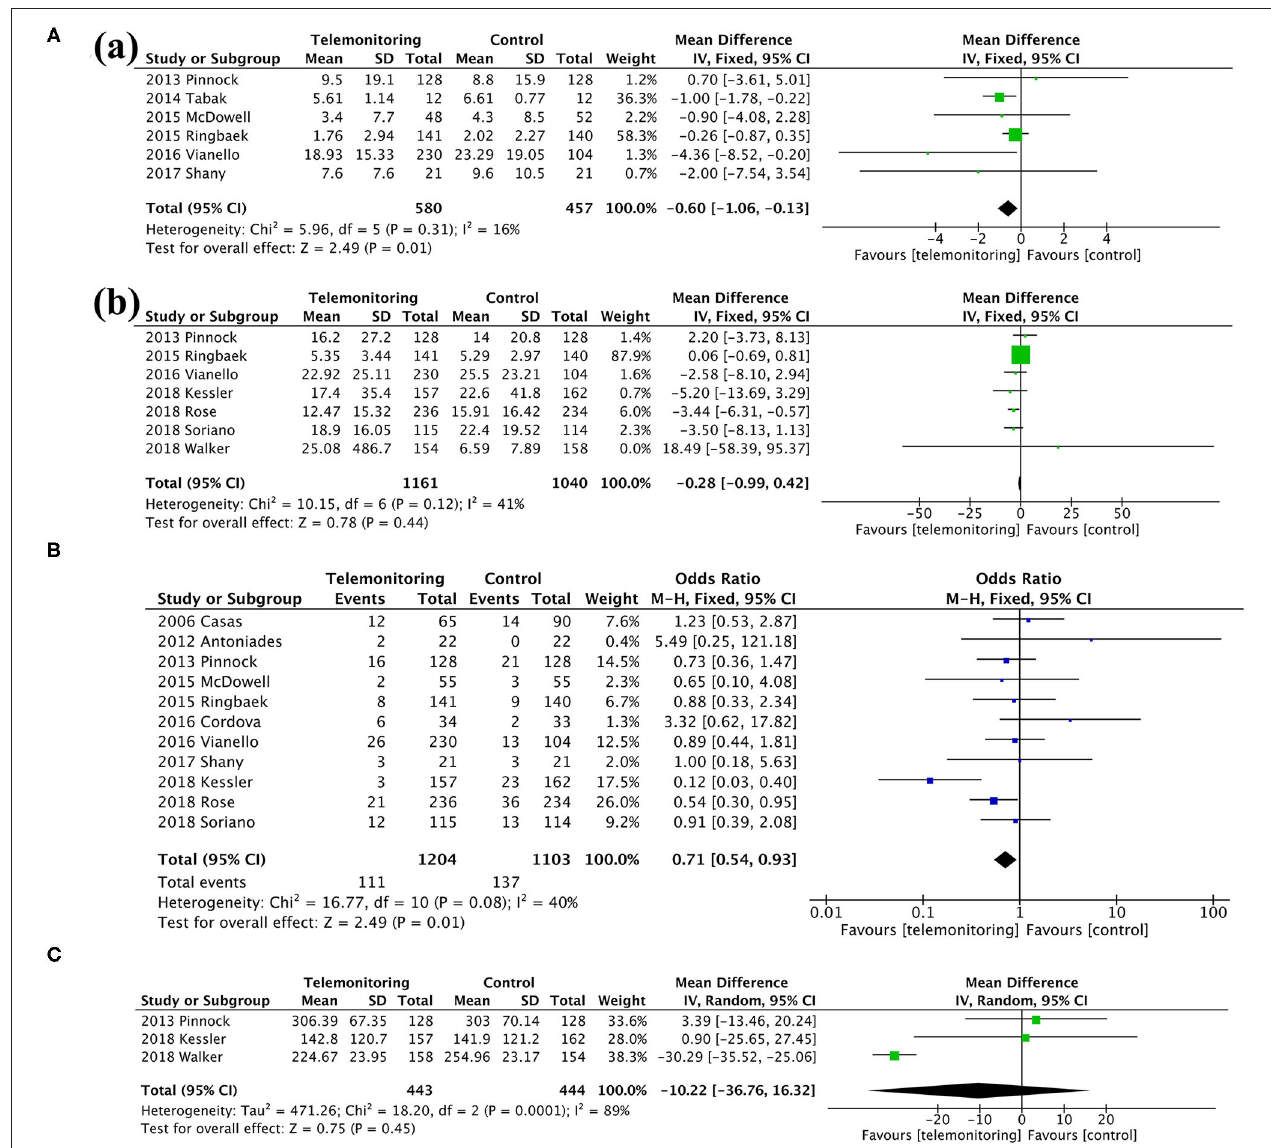
FIGURE 5 | A meta-analysis of secondary outcomes. (A) Length of stay: (a) exacerbation-related hospital days and (b) all-cause hospital days. (B) Mortality. (C) Time to first hospital readmission.